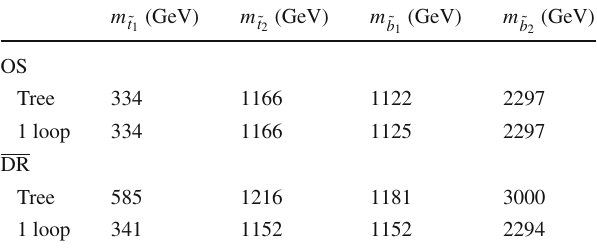
Table 5 Scenario2: The tree-level and one-loop corrected stop and sbottom masses in the DR and OS schemes